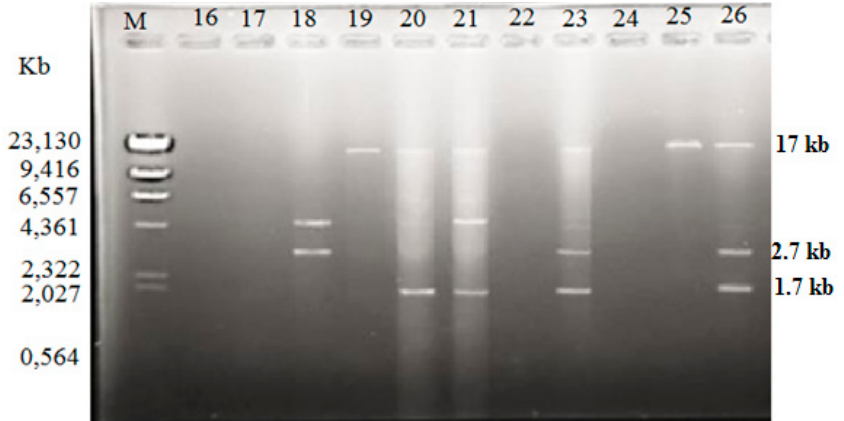
Figure 1. Example of plasmid profiles of Vibrio vulnificus isolated from Malaysia (strain 16–26) using a PureYield™ Plasmid Miniprep System on 1% ( w / v ) agarose gel. Lane M: Lambda DNA- Hind III DNA ladder. Lane 16–26: V. vulnificus strain 16–26.